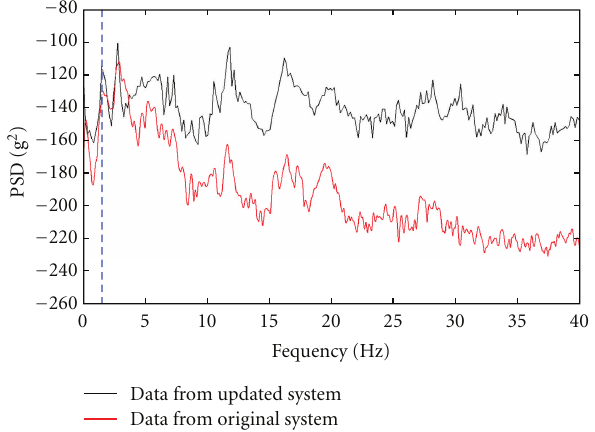
Figure 3: Autospectral density function of AV1 (vertical dashed line at fundamental natural frequency, 1.52